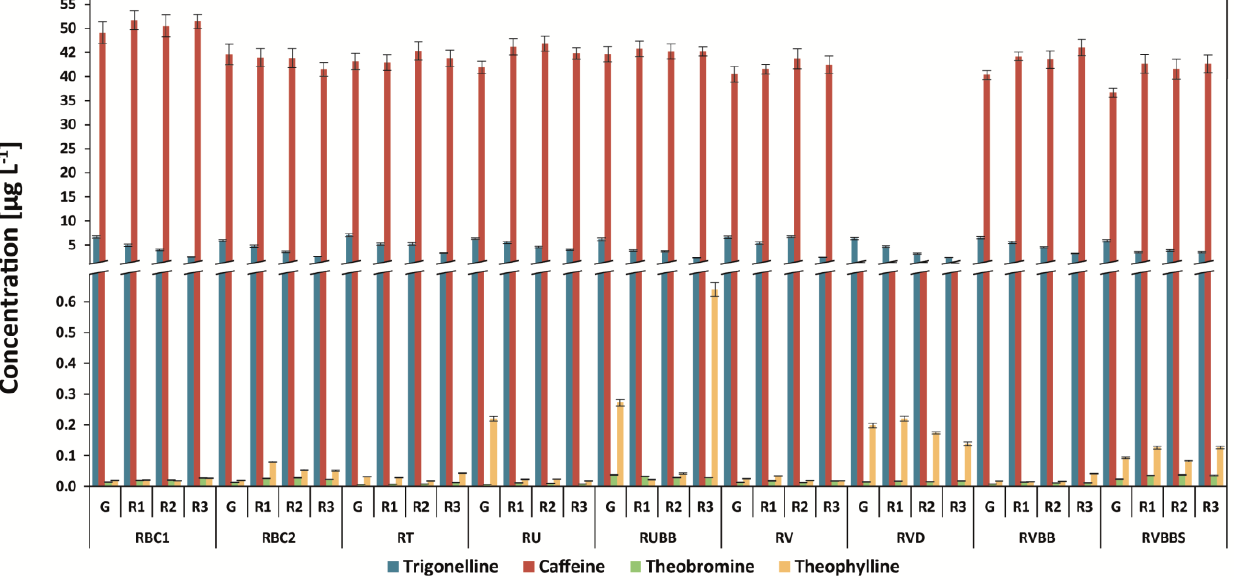
Figure 3. Methylxanthines and trigonelline content in Arabica coffee brews. Legend—Figure 1 capture.